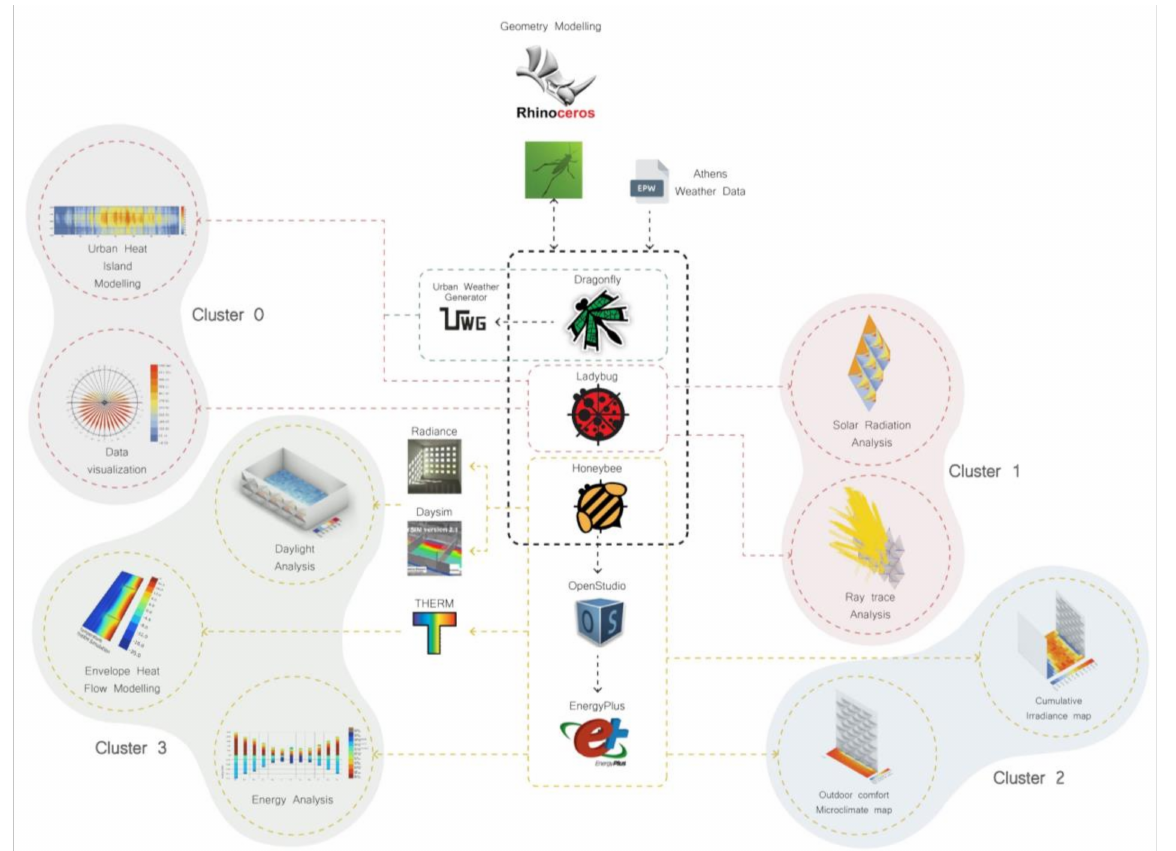
Figure 30. Subdivision of the followed computational workflow and clustering overview for the development of the digital tool.